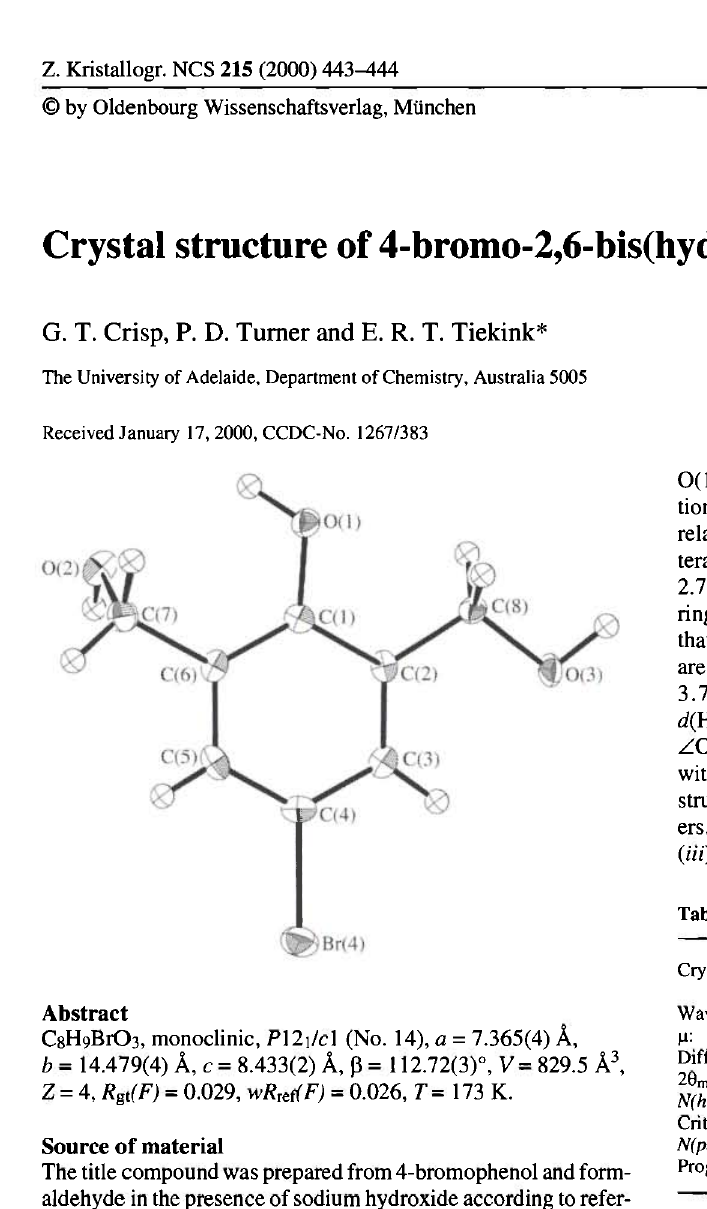
Table 2. Atomic coordinates and displacement parameters (in A 2